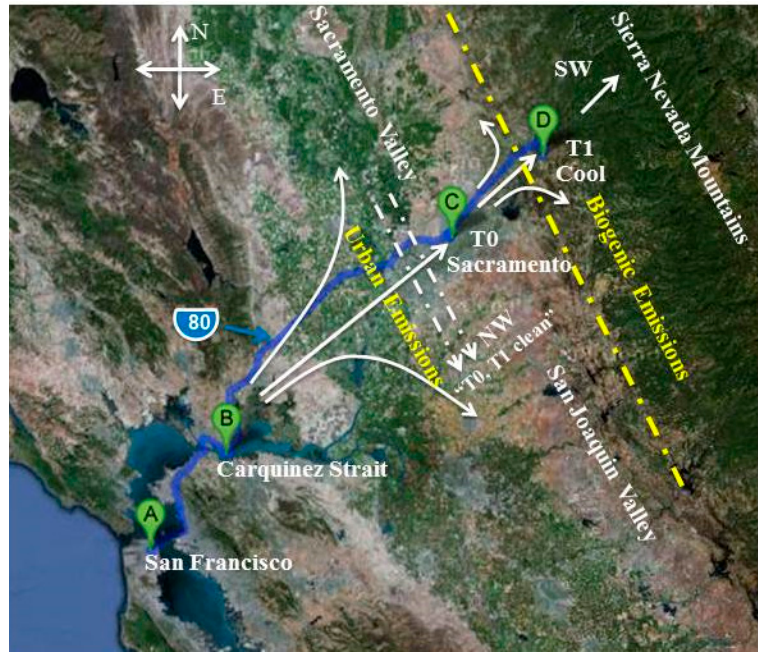
Figure1. Location of the ground sites, T0 and T1, along with a depiction of the dominant summer daytime wind patterns.